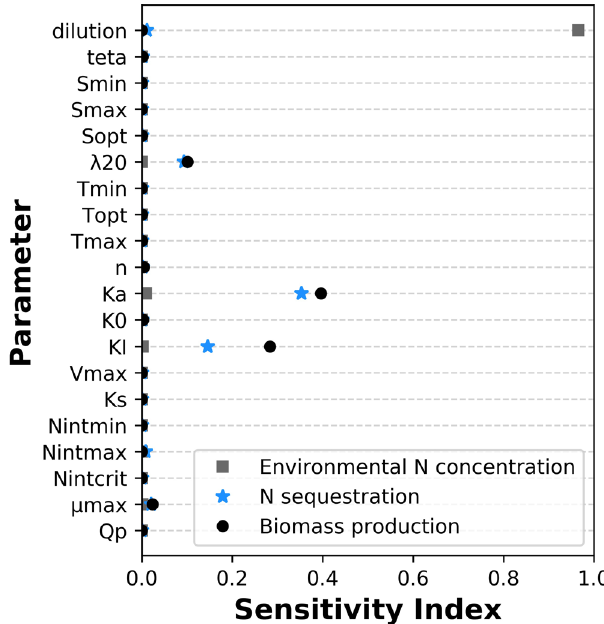
Fig. 2 Illustrated sensitivity of simulated biomass production, N sequestration and fi nal environmental N levels. Simulated biomass production (black circles), N sequestration (blue stars) and fi nal environmental N levels (gray squares) to model parameters, as measured by the Sobol